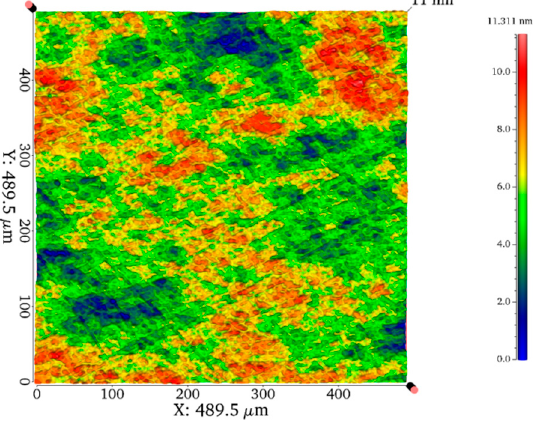
Figure 2. Top view of the surface morphology after precise polishing process.